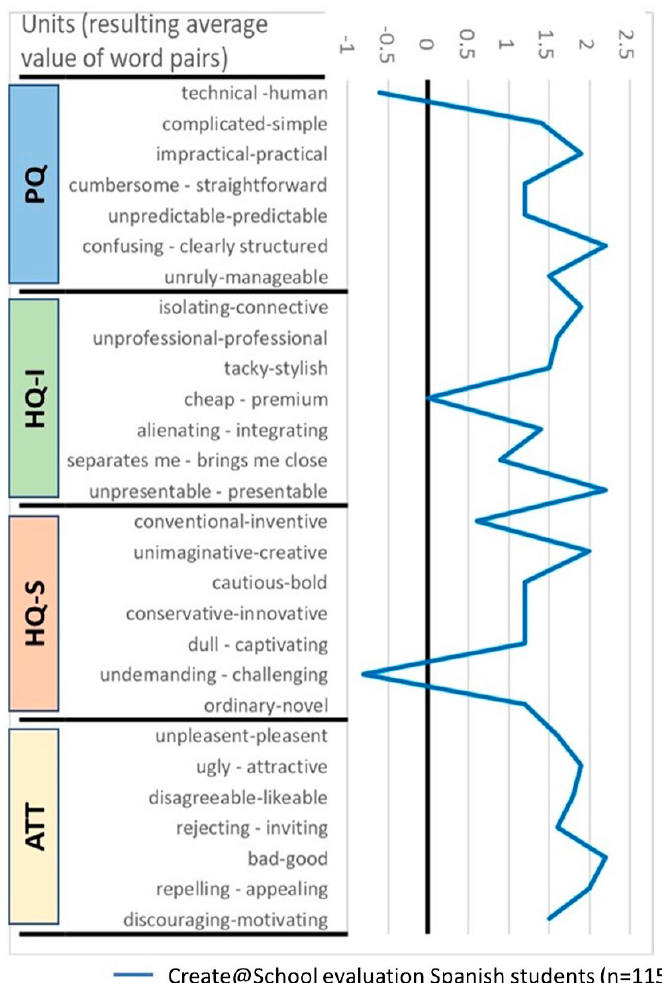
Figure 9. Diagram of the average of word pairs averages grouped by pragmatic qualities (PQs), hedonic identity quality (HQ-I), hedonic stimulation quality (HQ-S), and attractiveness (ATT) for the study 3.2.3 (adjusted scales to -1 to 2.5 for better visualization of results).